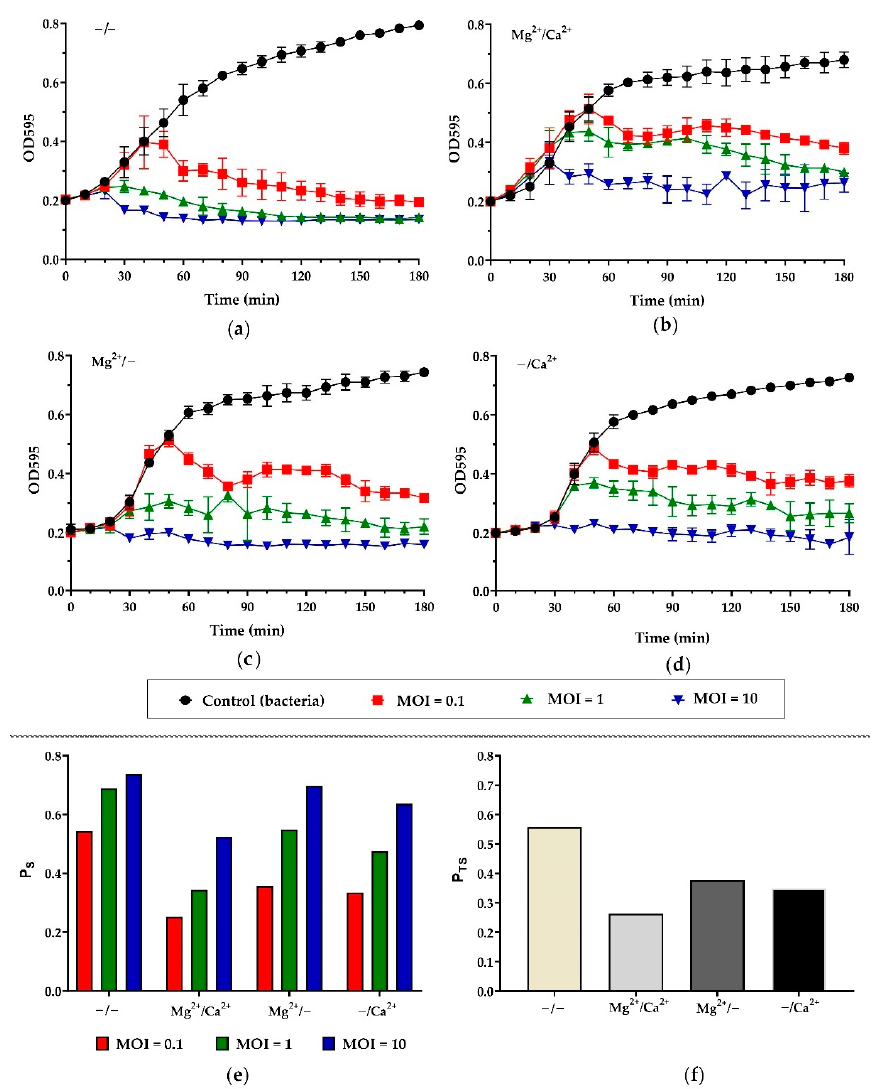
Figure 4. P. syringae BIM B-268 growth kinetics upon the infection with Pseudomonas phage Pf-10 at different MOI values. Killing activity of phage Pf-10 in: ( a ) the absence of Mg 2+ and Ca 2+ ions; ( b ) the presence of Mg 2+ and Ca 2+ ions; ( c ) the presence of only Mg 2+ ions; ( d ) the presence of only Ca 2+ ions. The graphs were created with GraphPad Prism 8.4.3. Values represent the mean of three independent trials, and error bars represent the standard deviation. ( e ) PhageScore factor (P S ) and ( f ) Phage Total Score factor (P TS ) values calculated for Pseudomonas phage Pf-10 for experiment the “ Killing Assay and Effect of Ca 2+ and Mg 2+ on the Killing Activity of Pf-10 ”.